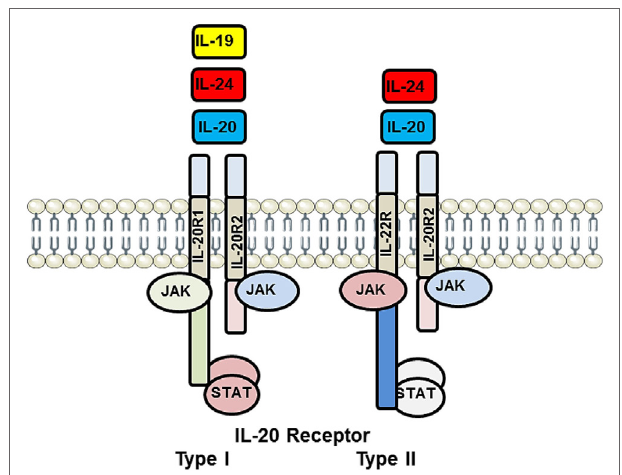
FigURe 1 | Illustration of interleukin (IL)-20 receptor system utilized by IL-19, IL-20, and IL-24. IL-20 receptor Type I is heterodimer composed of IL-20R1 and IL-20R2 and is recognized by IL-19, IL-20, and IL-24. IL-20 receptor Type II is a heterodimer composed of IL-20R2 and IL-22R and recognized only by IL-20 and IL-24. Each of these receptor complexes is capable of interacting with and activating a repertoire of JAK and STAT-signaling proteins. This multiplicity of ligand recognition and effector protein utilization offers combinational diversity in signal transduction and distal cellular processes. JAK, Janus Kinase; STAT, signal transducer and activator of